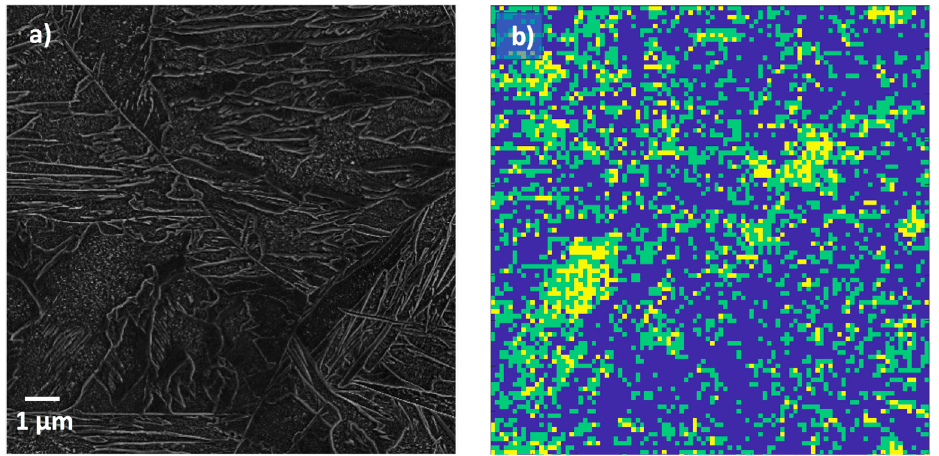
Figure 8. ( a ) SEM images of the Gleeble austenitized and subsequently water-quenched steel sample (1000 C/s). ( b ) Though the use of the custom MATLAB computer program, a color map that indicates the local area fraction of auto-tempered carbides within the highly auto-tempered regions. Apparent area fractions of auto-tempered carbides; > 10% yellow, 1–10% green, and < 1% blue.